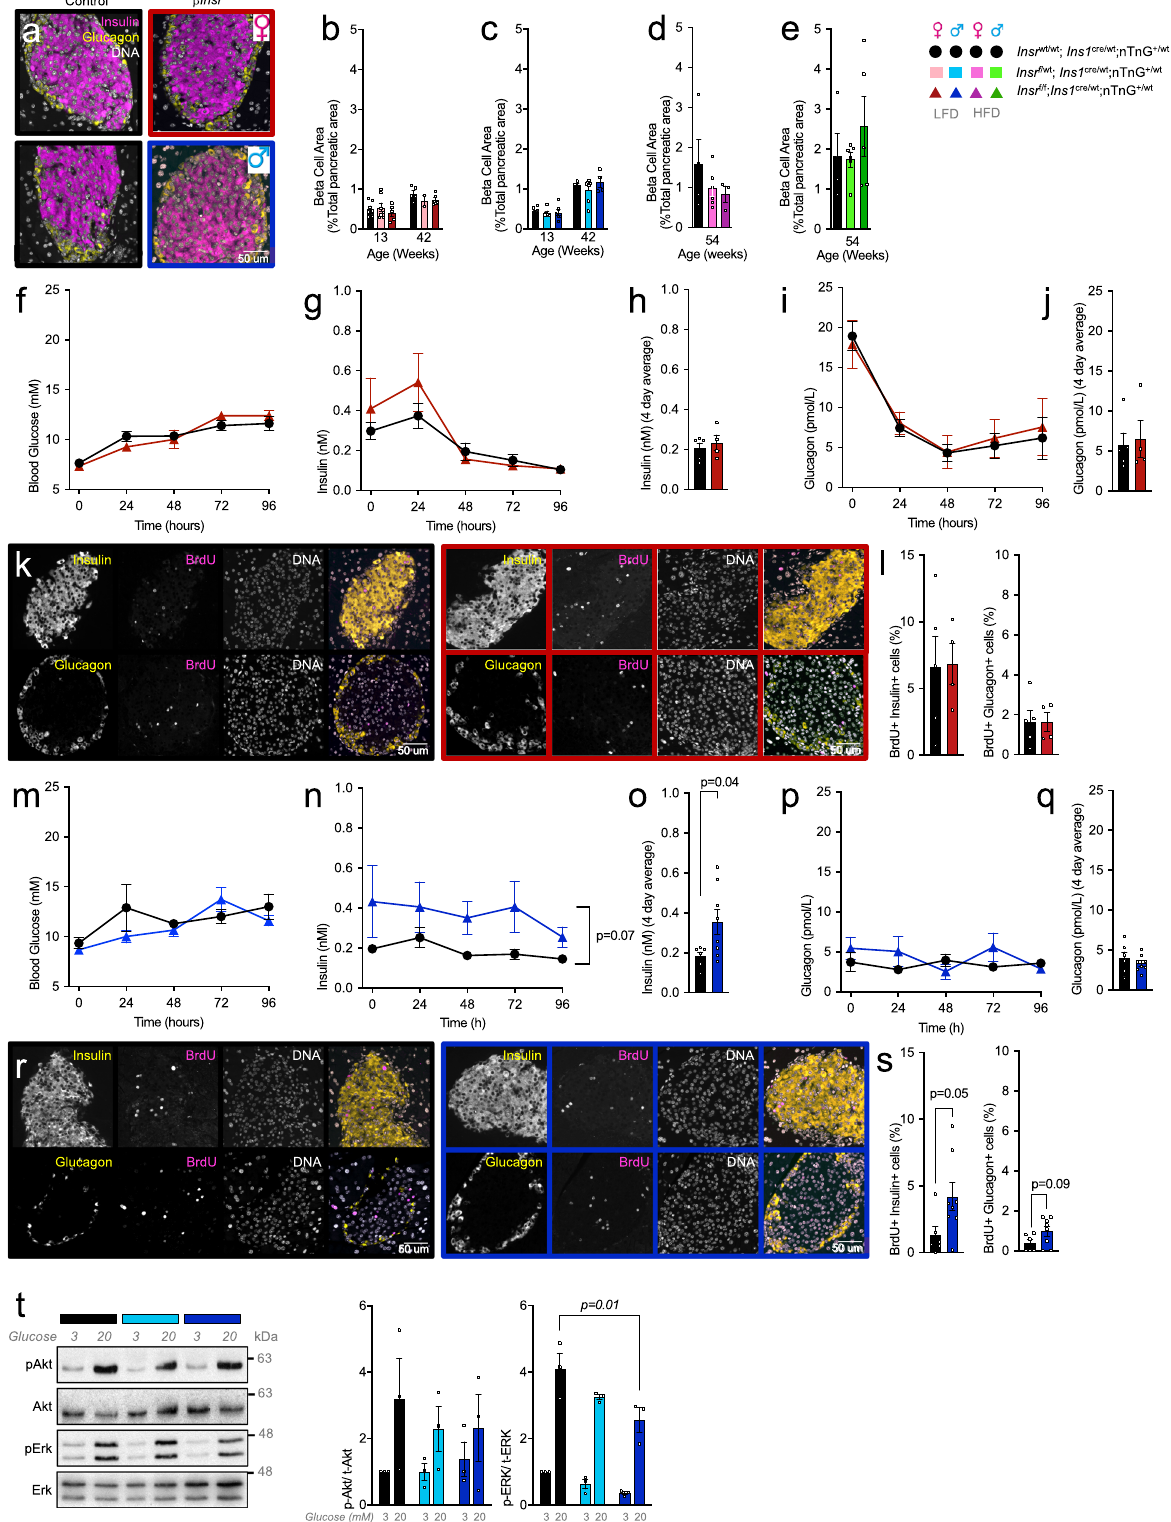
Acutely improved glucose tolerance with inducible β -cell- speci fi c Insr loss . The Ins1 cre allele results in pre-natal gene deletion 30 . To assess the effects of Insr deletion in adult β -cells, and to determine the role of Insr on a different genetic back- ground and under different housing conditions, we also pheno- typed multiple cohorts of male mice in which the Insr f/f allele